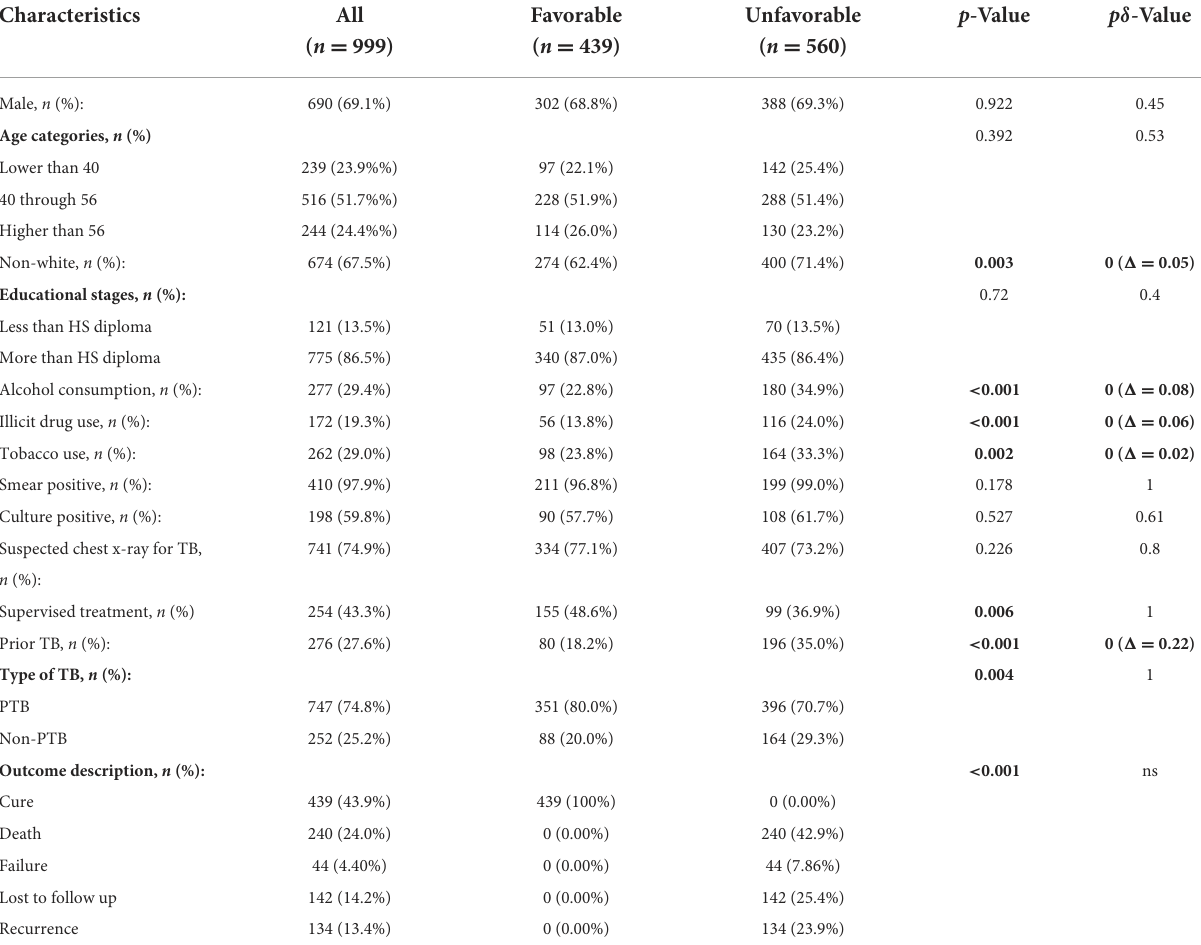
TABLE 3 Characterization of treatment outcomes in the TB-HIV-DM population.